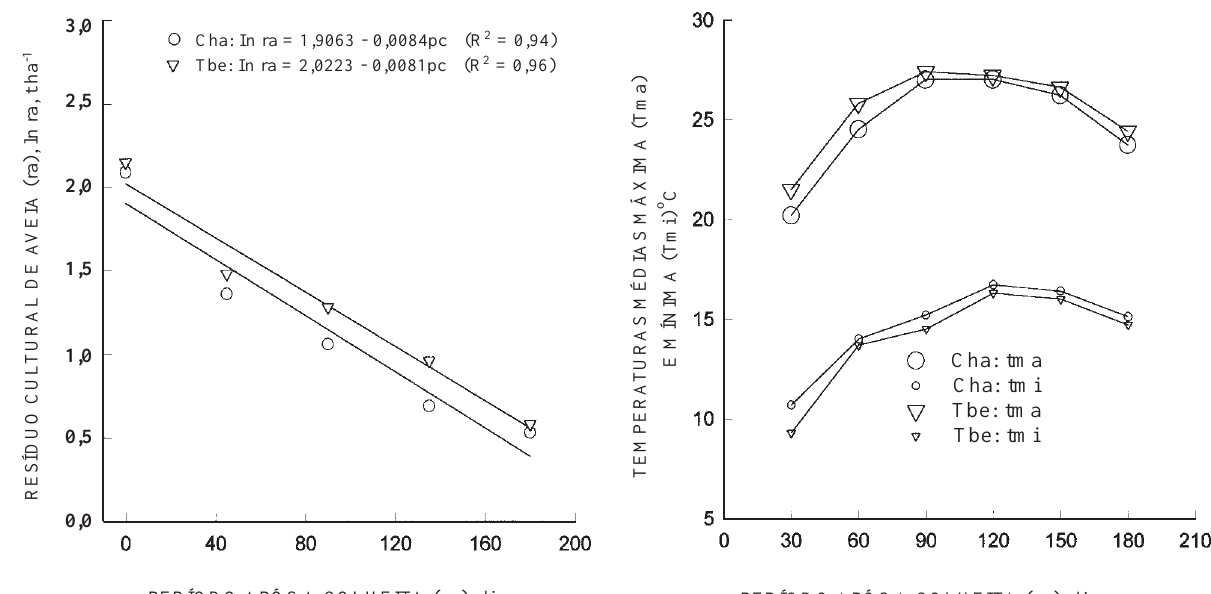
Figura 1. Persistência do resíduo cultural de aveia (ra), sobre a superfície do solo na semeadura direta, no Cambissolo Húmico álico de Lages (Cha), e na Terra Bruna Estruturada de Lebon Régis (Tbe), no período de 185 dias após a dessecação/rolagem da cultura (pc), de outubro de 1995 a abril de 1996.